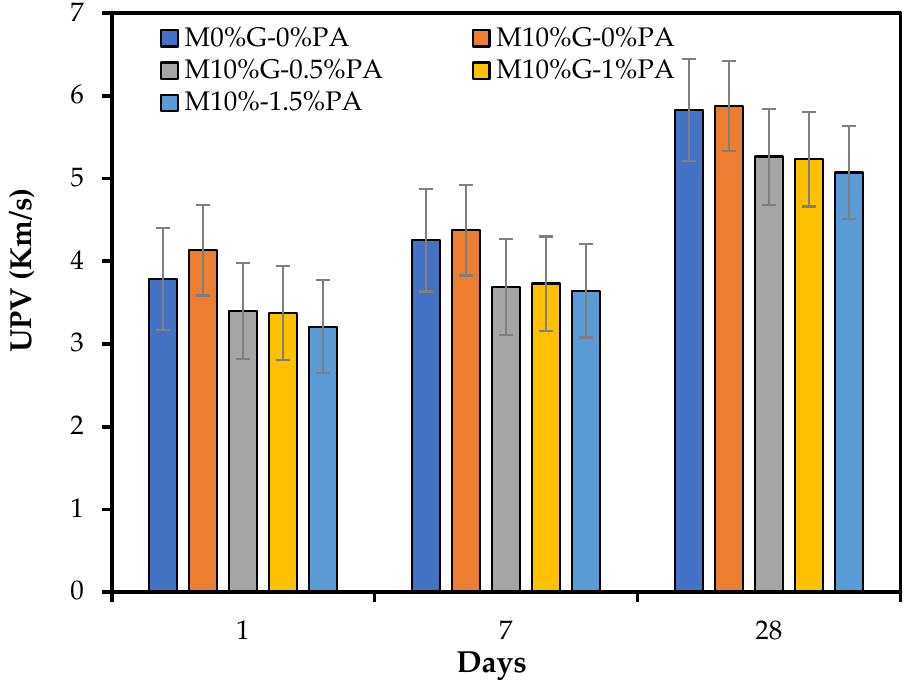
Figure 7. UPV for cubes with powder glass and PA fi bers (6 cubes/mix).